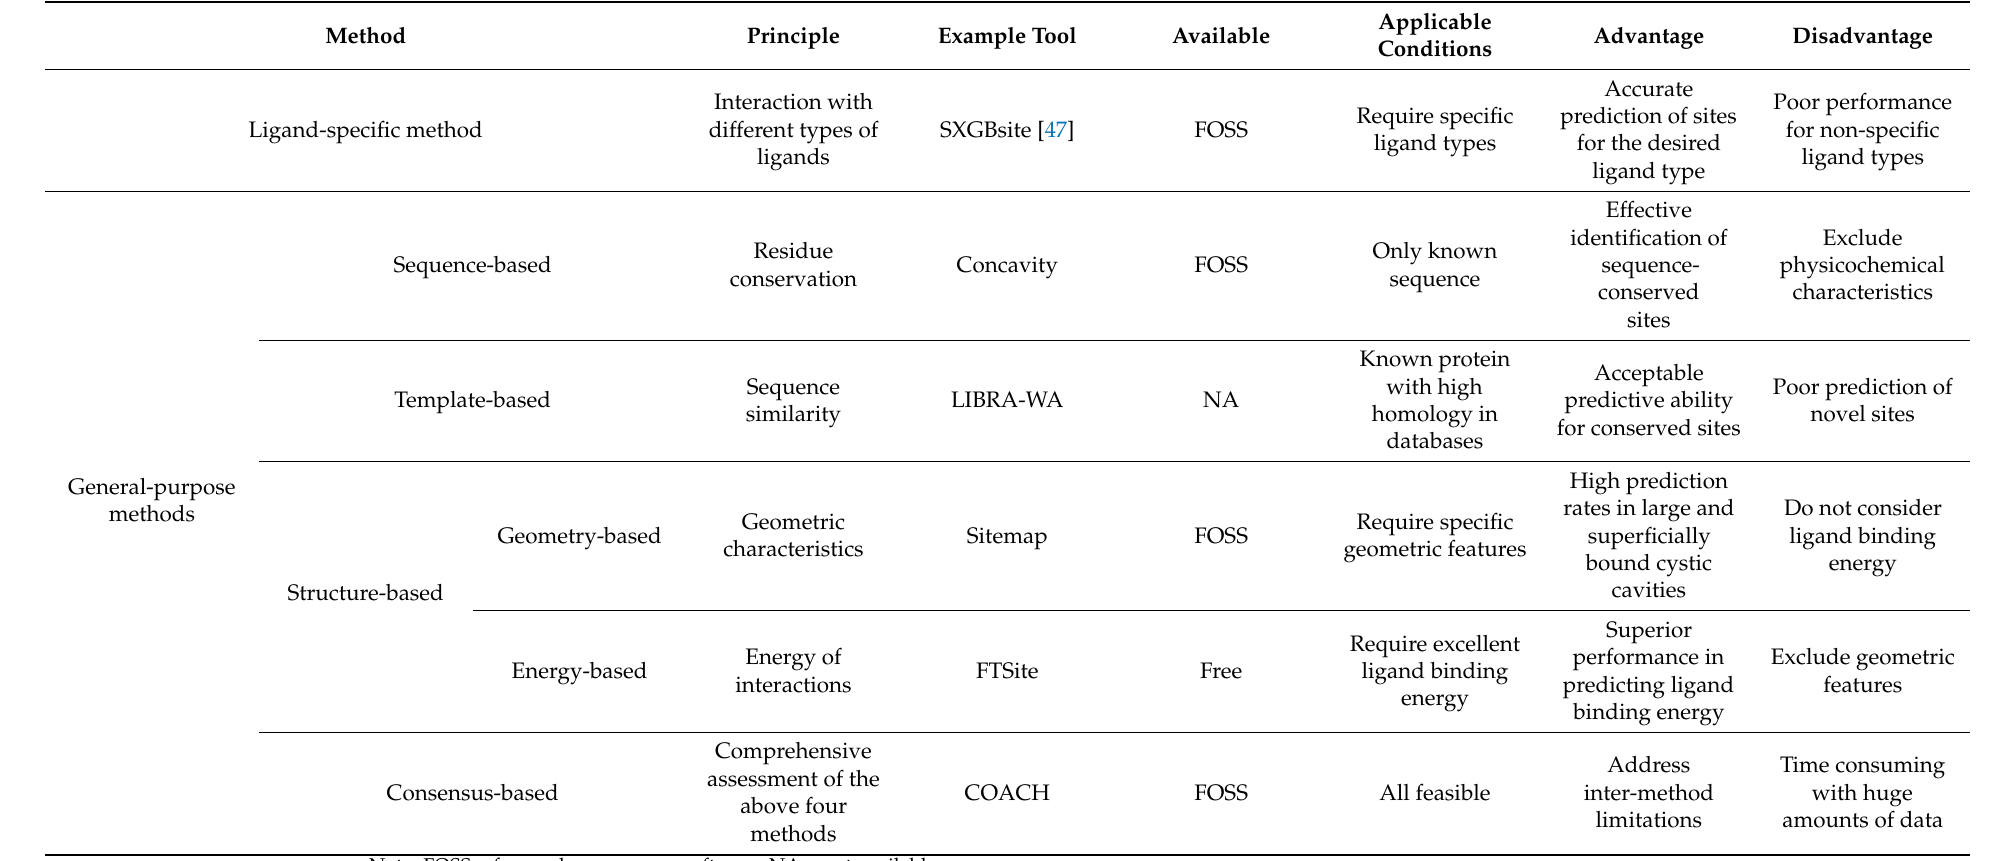
Table 1. Comparison of binding site identification